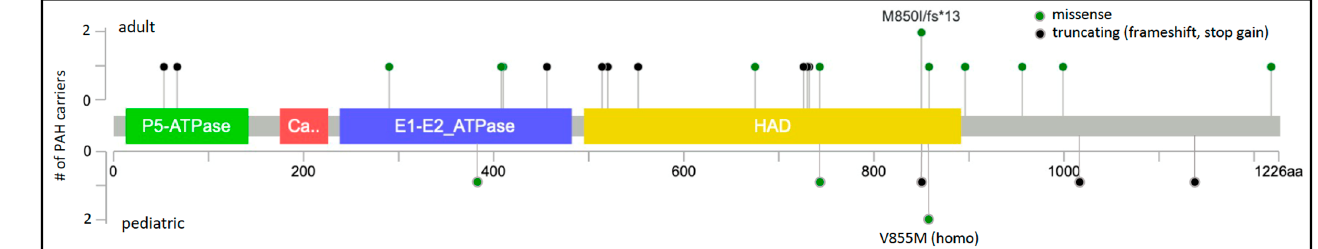
Figure 2. ATP13A3 two-dimensional protein schematic. Variants identified in adult-onset PAH cases are shown above the protein schematic; variants identified in children are shown below. Variant type is color-coded. The number of PAH carriers identified with a particular variant is shown along the y -axis. Conserved protein domains are indicated by colored rectangles. E1-E2_ATPase, cation transporter ATPase; HAD, haloacid dehalogenase-like hydrolase. Map generated using MutationMapper at cBioPortal.org, accessed on 2 January